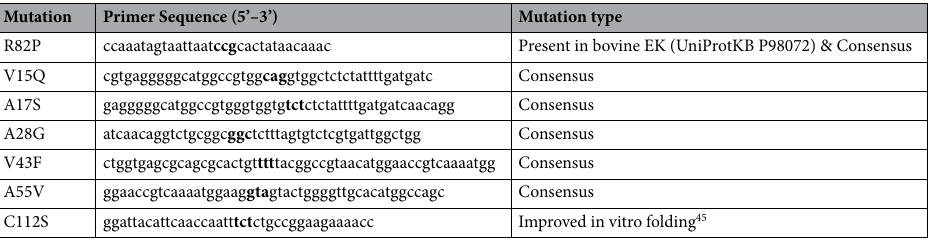
Table 1. Mutant primers for site-directed